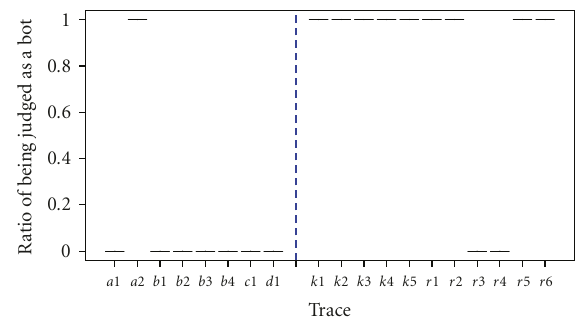
Figure 17: Bot identification results using the pacing